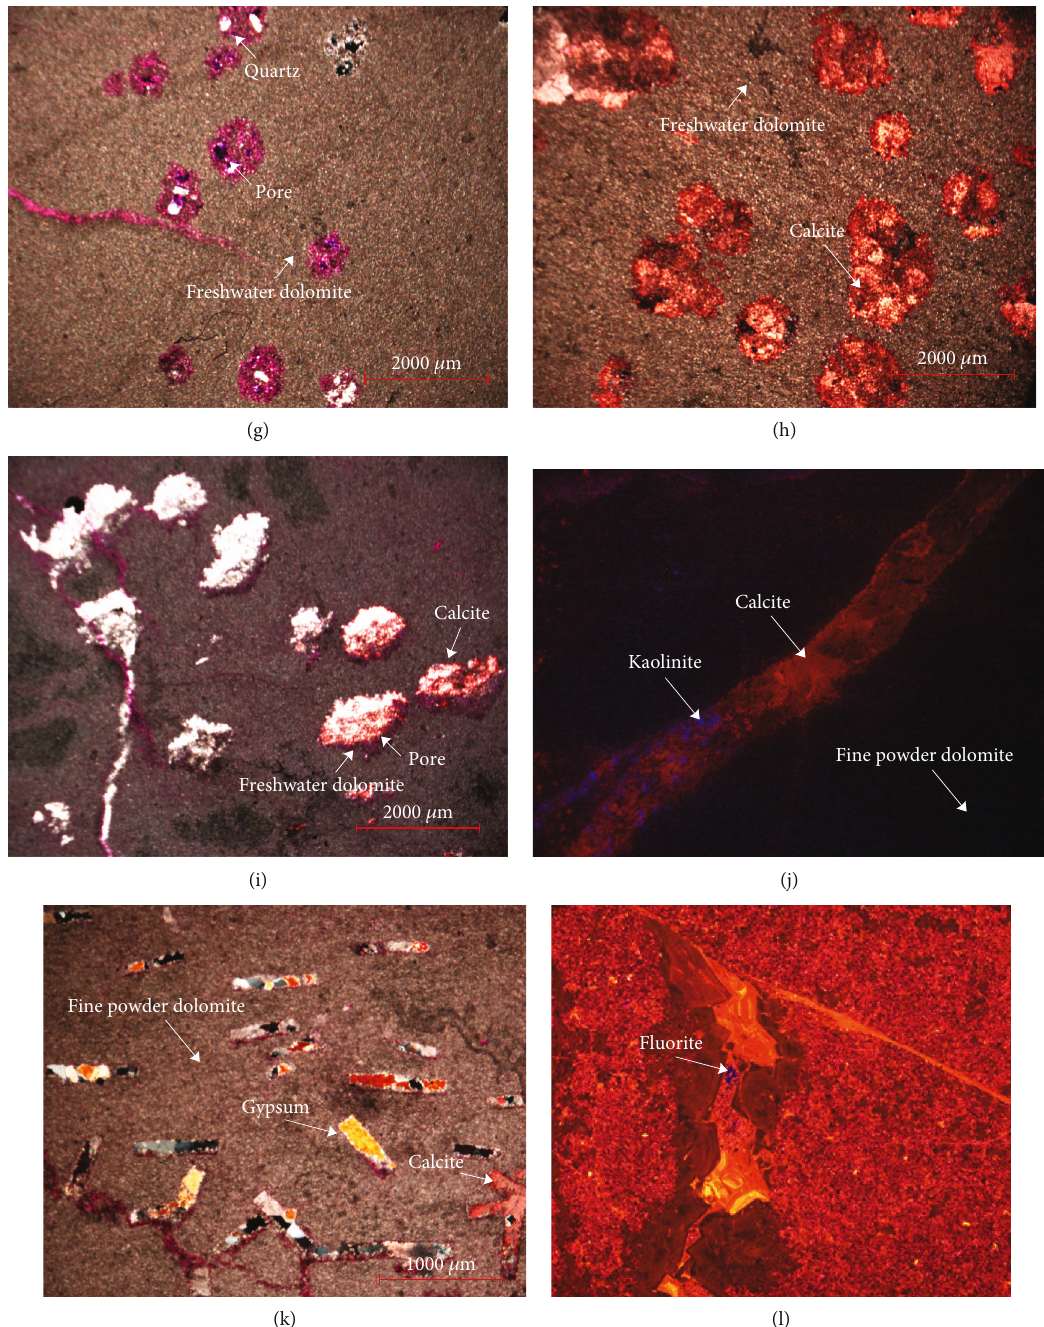
Figure 4: Photos of reservoir rock types and fi llings in M5 submember of Majiagou Formation. (a) Crystal dolomite, moldic pores in 1-2 anhydrite accretions. (b) Fine-powder dolomite, fracture development. (c) Karst breccia dolomite, dissolution pores between breccias. (d) Photomicrograph showing fractures fi lled with granular calcite and coarse-grained calcite. (e) Optical CL photomicrograph of ferrocalcite is fi lled in the fracture. (f) Optical CL photomicrograph of ferrodolomite is fi lled in moldic pores. (g) Plane light optical photomicrograph of moldic pores in anhydrite accretions, completely fi lled with freshwater dolomite. (h) Plane light optical photomicrograph of moldic pores in anhydrite accretions, completely fi lled with calcite. (i) Plane light optical photomicrograph of the fracture is fi lled with saddle dolomite. (j) Optical CL photomicrograph of the fracture is fi lled with calcite and kaolinite. (k) Plane light optical photomicrograph of gypsum crystals, fi lling calcite in tabular moldic pores in gypsum. (l) Optical CL photomicrograph of fl uorite is fi lled in the